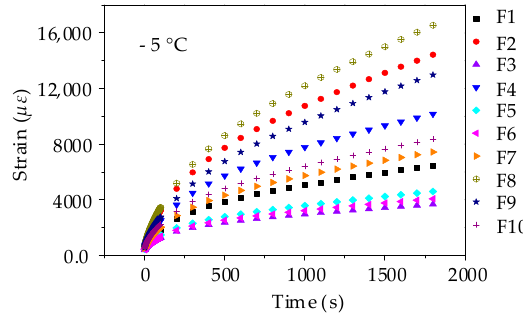
Figure 15. Creep strain ‐ time curves of asphalt mortar beams.